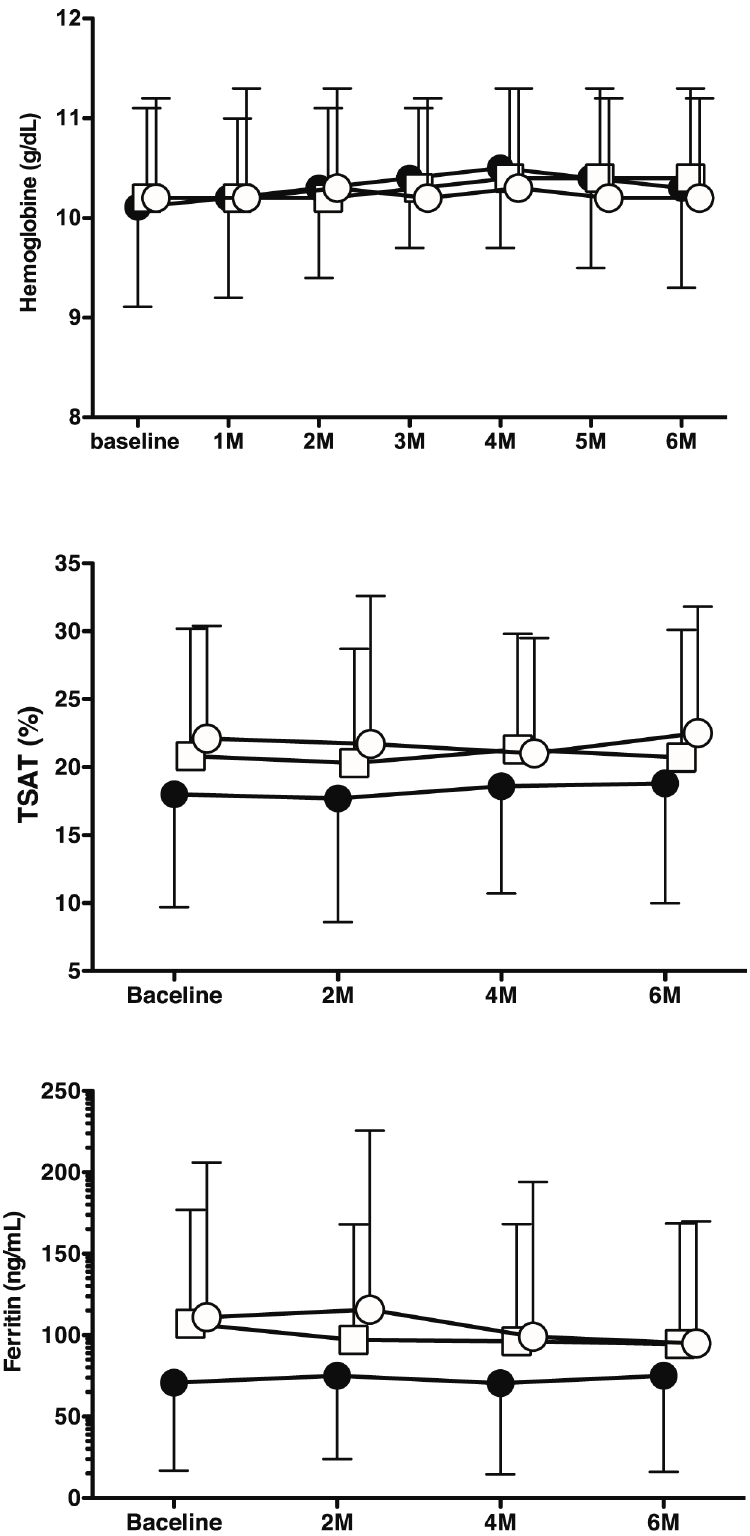
Fig 1. Changesin hemoglobin (a), transferrin saturation (TSAT) (b), and ferritin (c) over 6 months among intact fibroblast growth factor 23 (i-FGF23) tertiles: closed circle, higheri-FGF23 tertile; opensquare, middle i- FGF23 tertile; open circle, lower i-FGF23